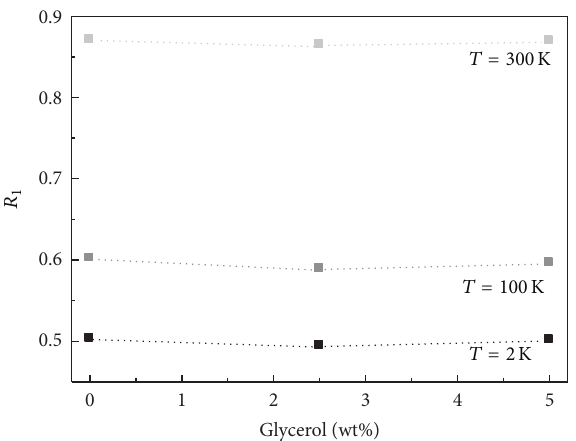
Figure 4: 𝑅 1 parameter behaviour as a function of glycerol concen- tration for trehalose/glycerol mixtures at T = 2K by IN4, T = 100K by OSIRIS, and T = 300 K by